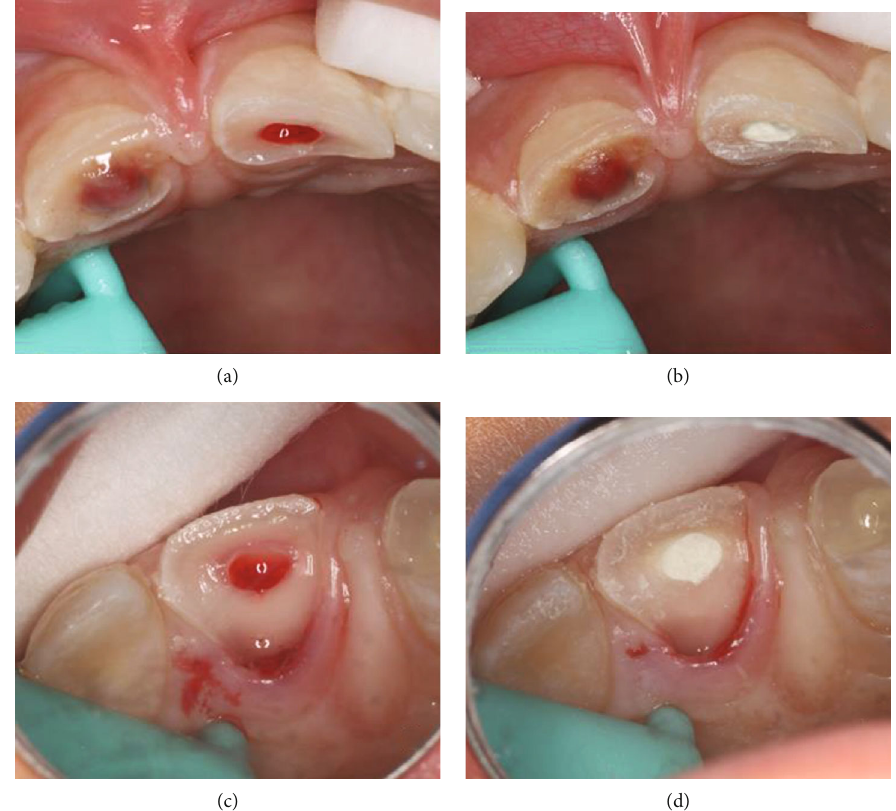
Figure 5: Pulpotomy of tooth no. 21 (a and b) and tooth no. 11 after removal of the palatine tooth fragment and after partial pulpotomy (c) with MTA application (d).